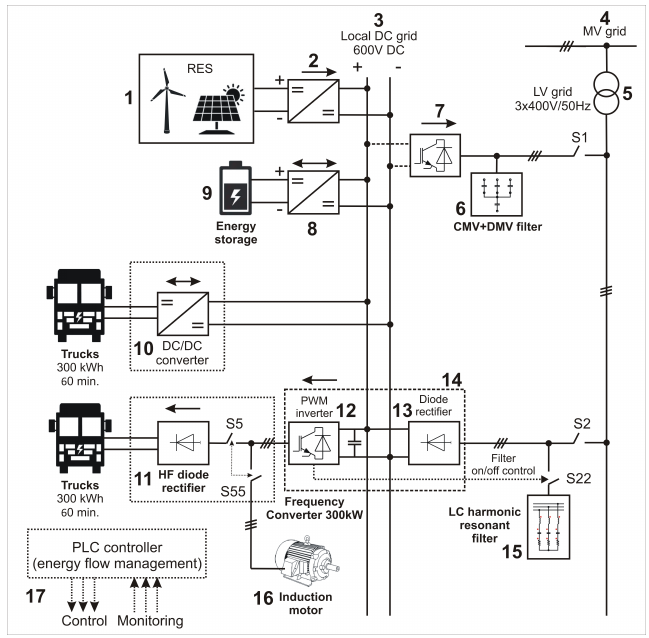
Figure 8. Hybrid 600 V DC microgrid for EV fast charging.